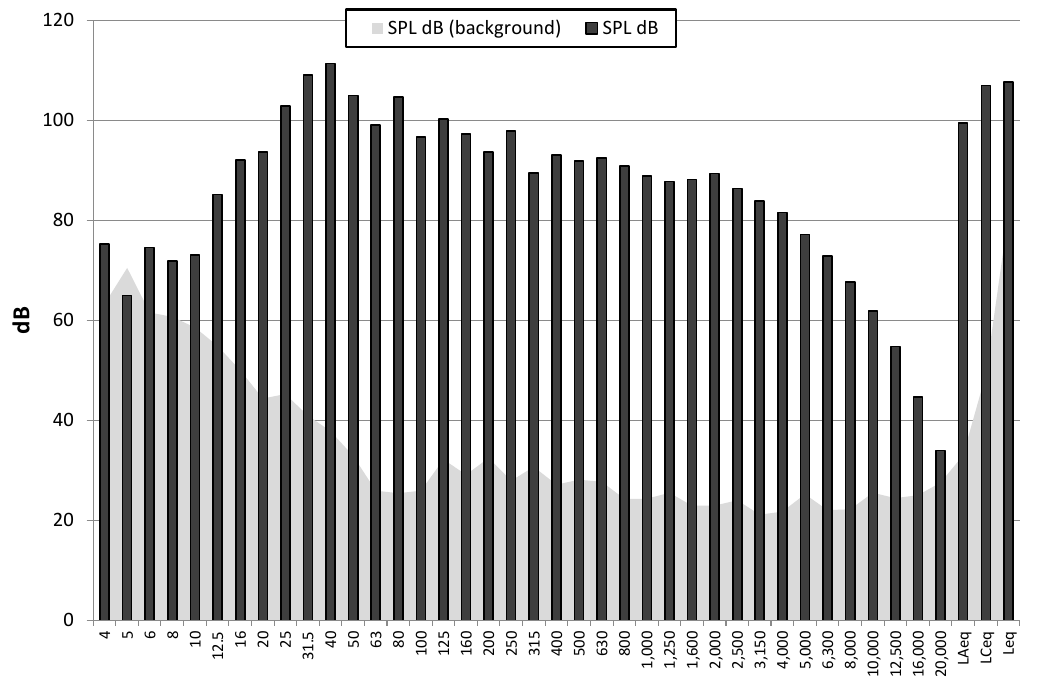
Figure 22. Spectrum of maximum SPL (unweighted) in one-third octave bands—250 g explosive charge on the surface and background noise (SPL dB (background))-Station 3.